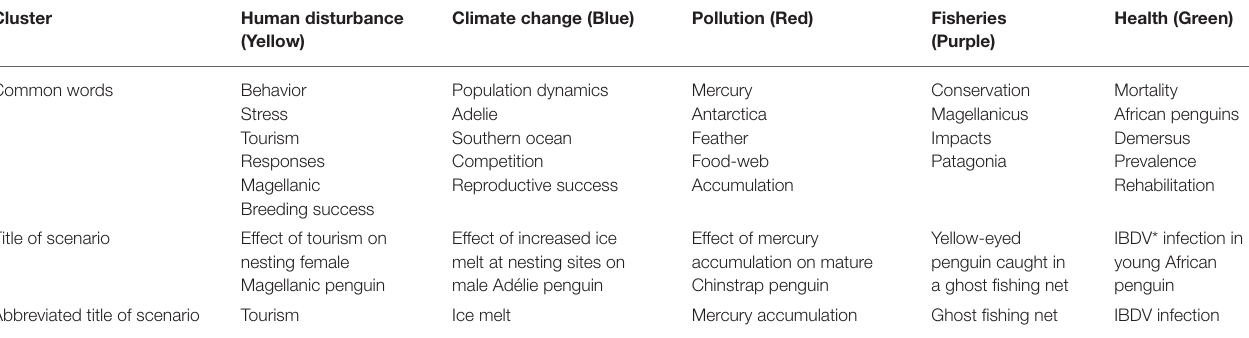
TABLE 1 | Most common words in the five clusters of articles on anthropogenic effects on penguins identified by VOSviewer, and titles of the five scenarios.